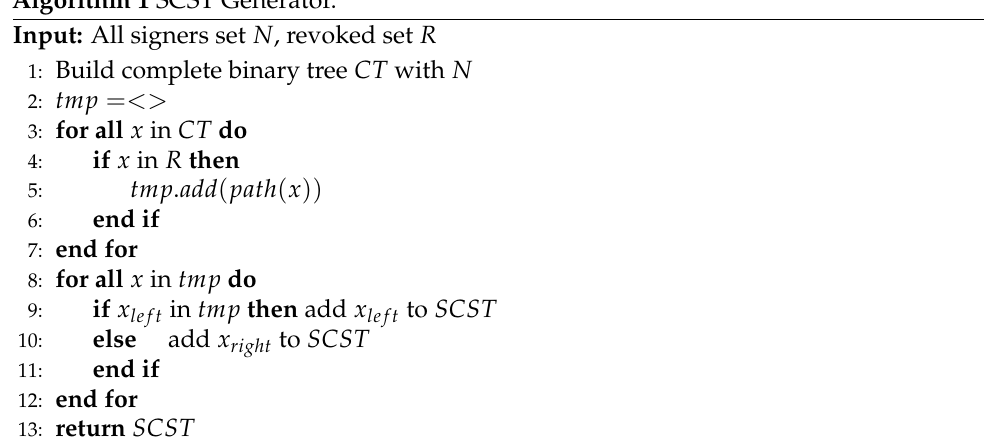
Algorithm 1 SCST